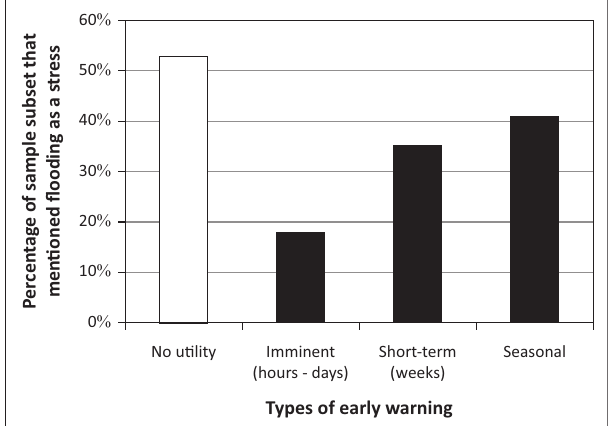
FIGURE 5: Types of desired early warning in Kasaya. Percentages sum to more than 100 % because several residents expressed interest in more than one type of early